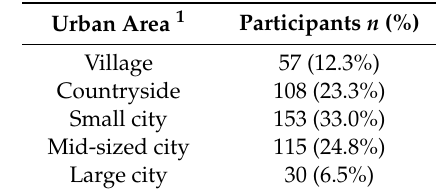
Table 1. Frequencies of the areas where the participants lived.